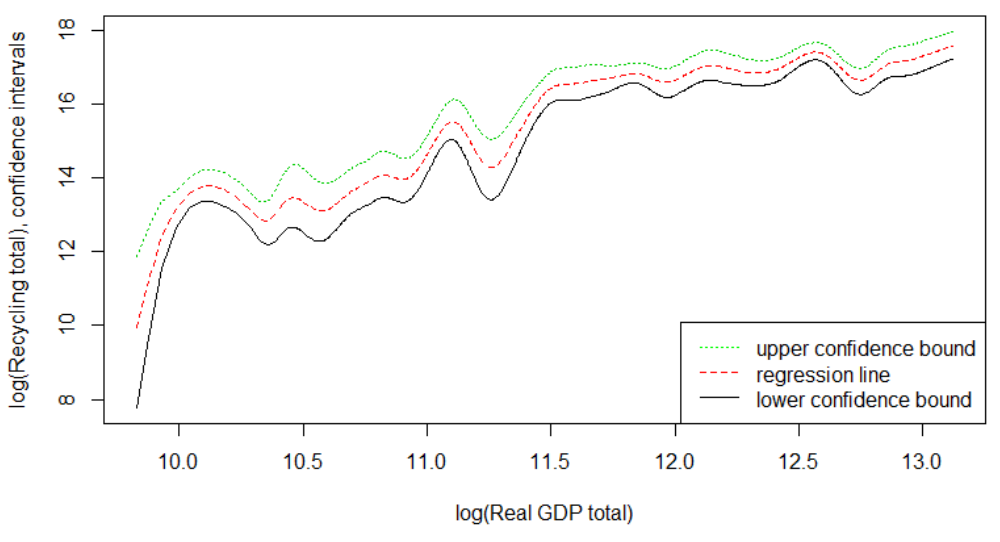
Figure 5. Relationship between log of total Recycling and log of total Real GDP.